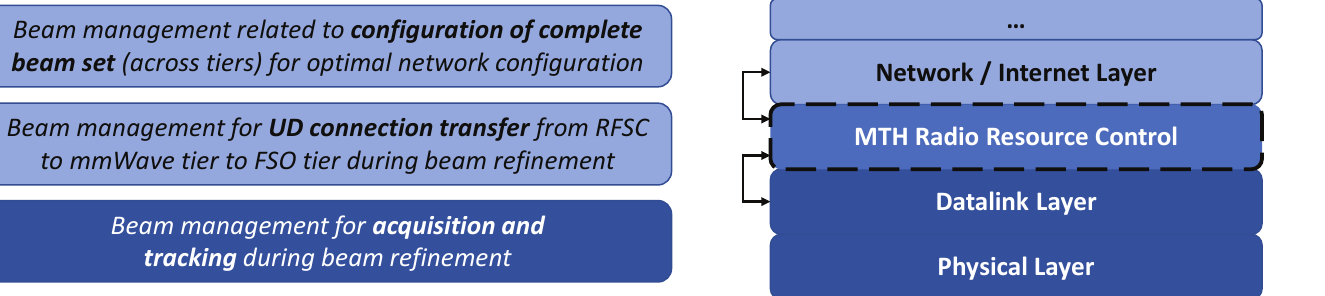
Figure 4. MTH radio resource control for beam management in the TCP/IP 5-layer model.